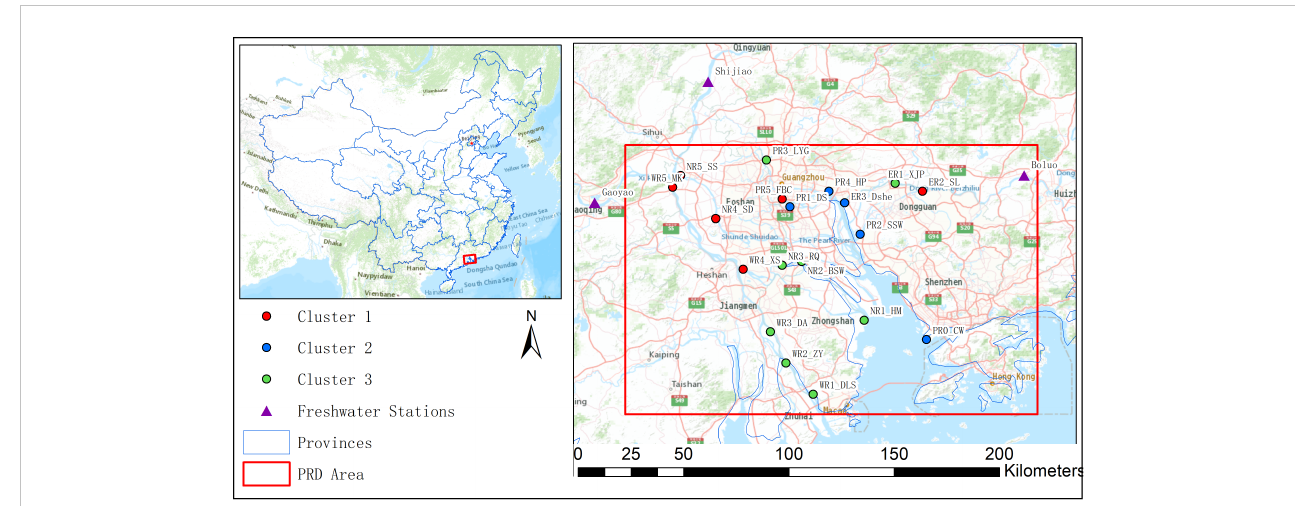
FIGURE 1 Location of Pearl River Estuary (PRE) and the selected stations (Stations of different clusters were grouped in the